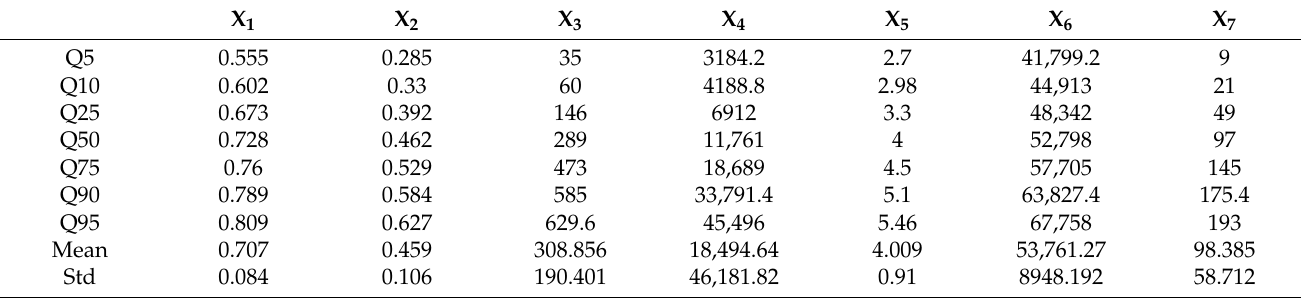
Table A4. Descriptive statistics for cluster